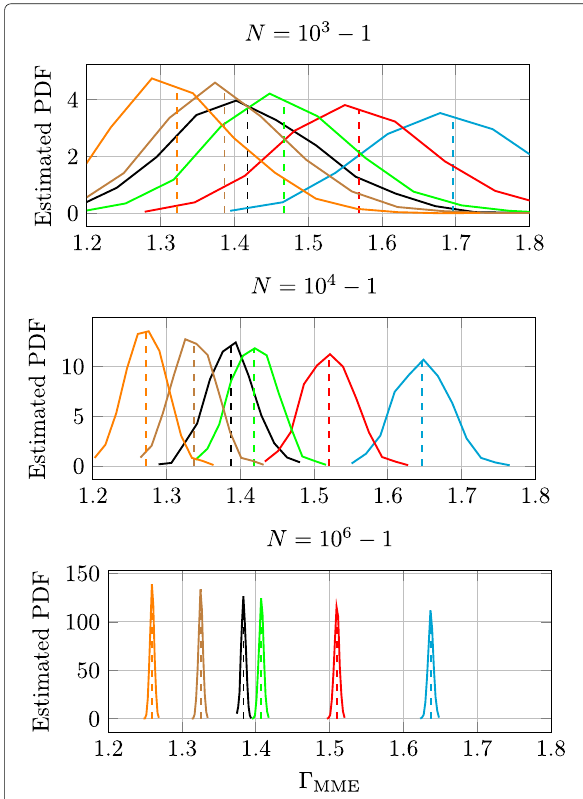
Fig. 4 Estimated probability density function for time correlation ( p = 1, Q = 4) and different N . Solidlines represent the histograms, while dashedlines depict the means. The H 0 case result is shown in black , while the H 1 case results are colored , where the SNR from right to left is given by {− 6, − 7, ... , − 10 }